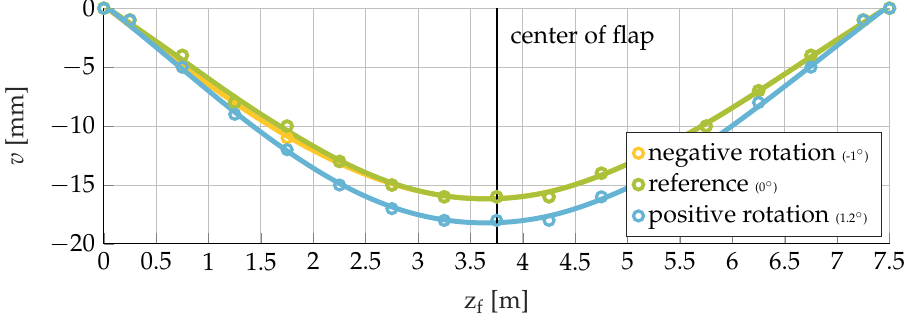
Figure 13. Deflection of the flap by a rotation around x-axis. Experiments with an earlier version of the end effector (see Figure 14) show that a low stiffness in the interfaces between the Stewart platform and the flap module can be beneficial. In this earlier version, the interfaces connecting the Stewart platform to the main beam and the flap are significantly less stiff. The deformation shown in Figure 15 was generated without using the maximum actuator forces, since the corner elements connecting the aluminum extrusions failed. Despite the lower forces, the maximum deformation v of the flap is bigger than the deformation, which is generated by the stiff interfaces (4.5 mm vs. 2 mm) (see Figures 13 and 15); therefore, it can be assumed that the low stiffness of the interfaces allowed the flap to bend more closely to its deflection curve, lowering the needed actuation